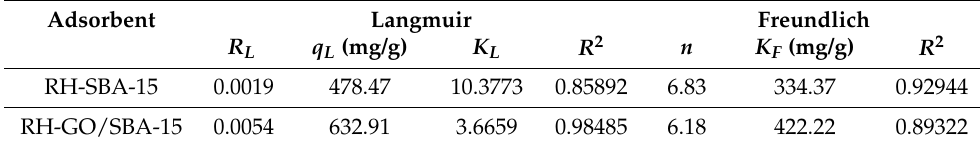
Table 4. Isotherm parameters for dye adsorption onto two types of